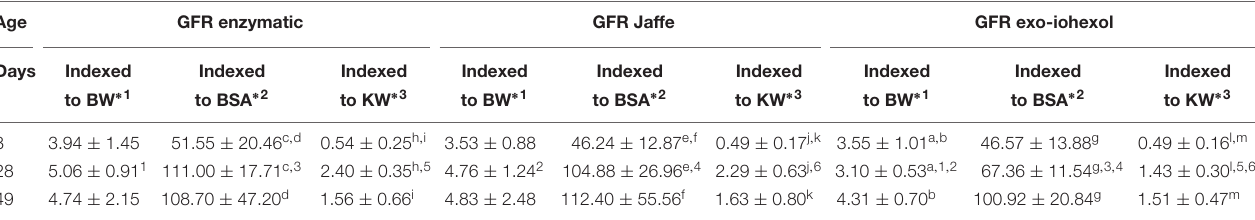
TABLE 2 | Glomerular filtration rate measurements (GFR, mean ± SD) with Jaffe, enzymatic creatinine assay and exo-iohexol in growing piglets aging 8 days ( n = 14), 4 weeks (28 days, n = 8), 7 weeks (49 days, n = 16).